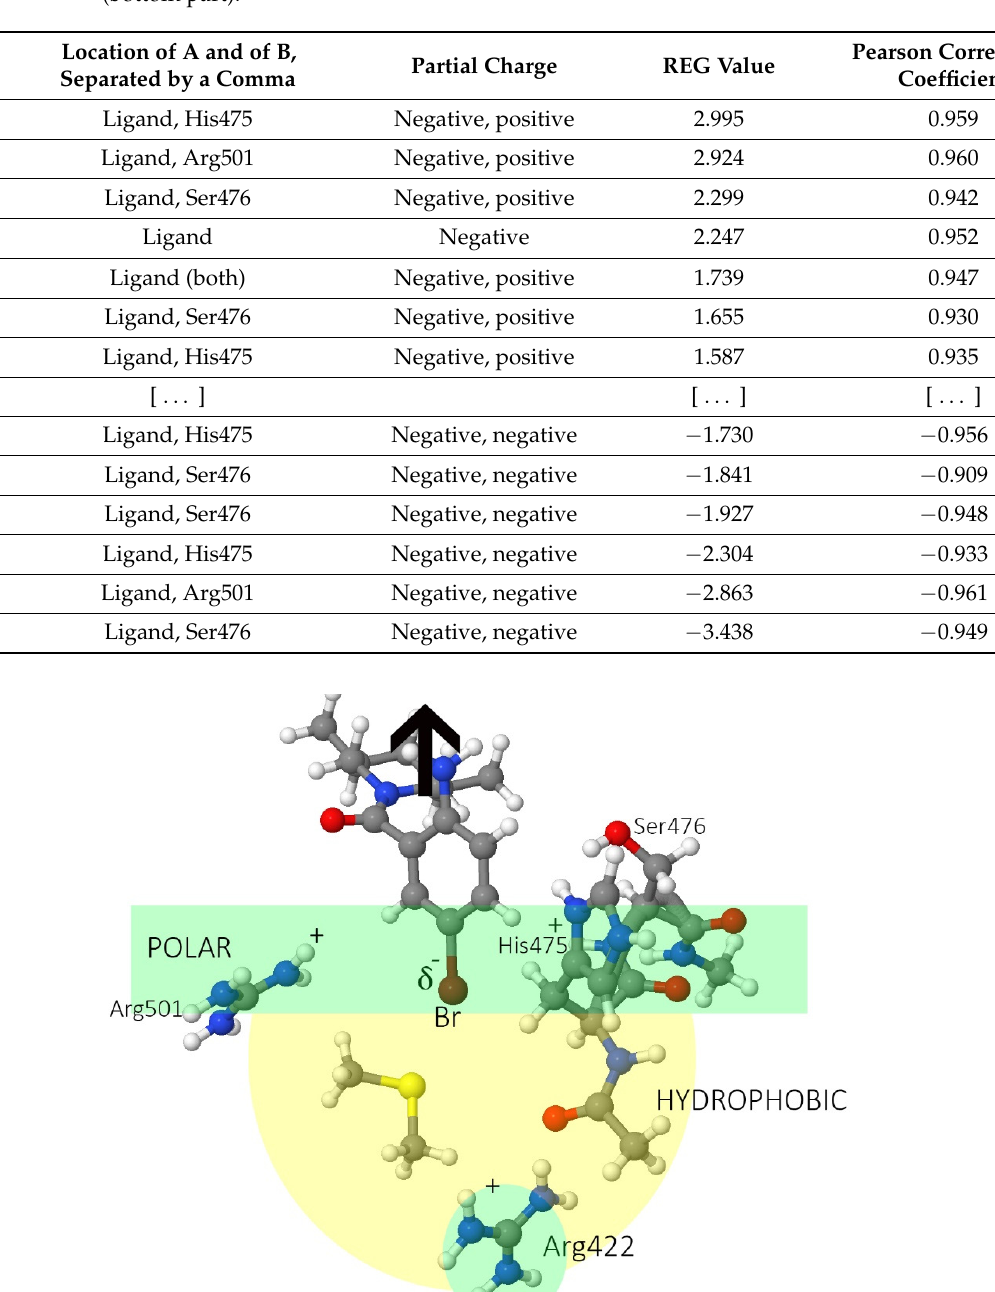
Figure 7. Geometries associated with key points (blue) on the full system’s PES (red curves) of 3CJ2 as its ligand moves away from panel ( a – f ) crossing all four segments. The local maximum and local